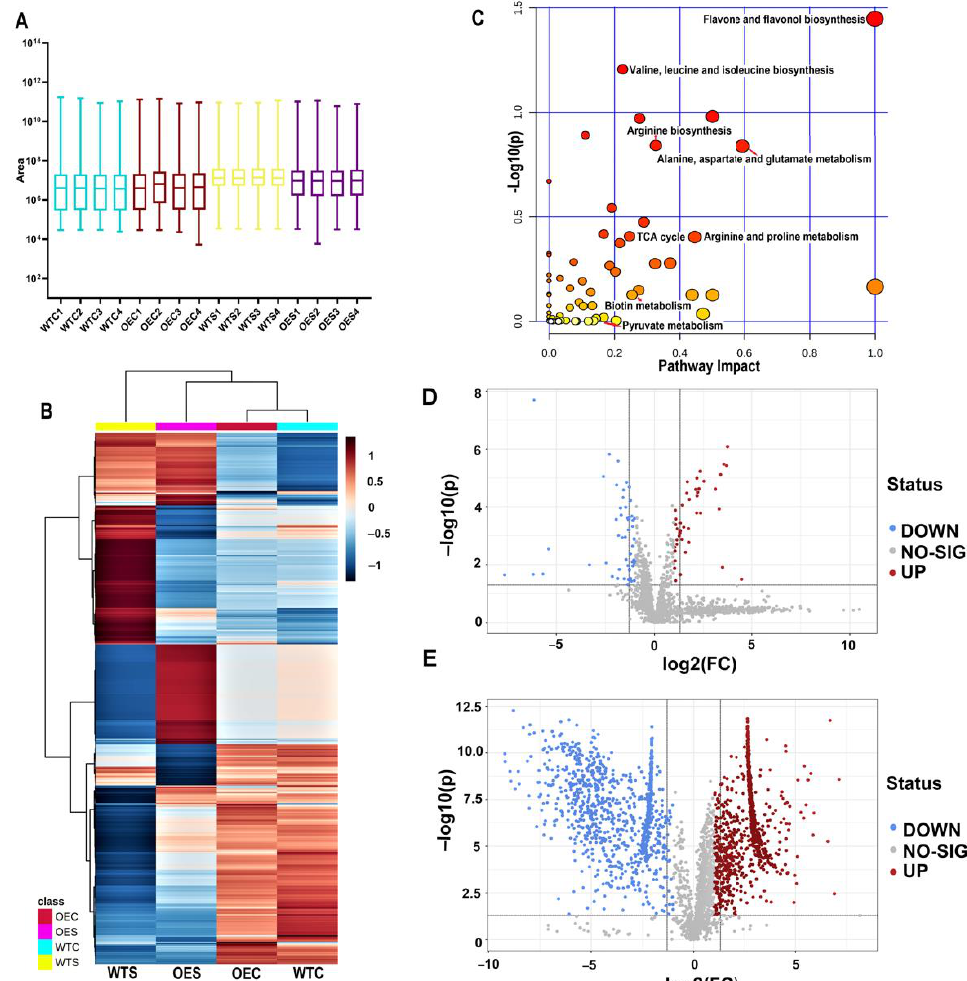
Figure 5. Metabolomic analysis of OE and WT under control and salt stress conditions. ( A ) Box plot showing the median, interquartile range (box), and maximum and minimum scores for each data set. WTC1-4, wild-type Arabidopsis irrigated with water, four biological replicates contained. OEC1-4, McHB7 -OE Arabidopsis irrigated with water. WTS1-4, wild-type Arabidopsis treated with 200 mM NaCl for seven days. OES1-4, McHB7 -OE Arabidopsis treated with 200 mM NaCl for seven days. ( B ) Heatmap of identified metabolites in OE and WT under control and salt stress conditions. ( C ) Pathway enrichment of identified metabolites. ( D ) Significantly changed metabolites in OE compared to WT under control conditions. ( E ) Significantly changed metabolites in OE compared to WT after salt stress treatment.